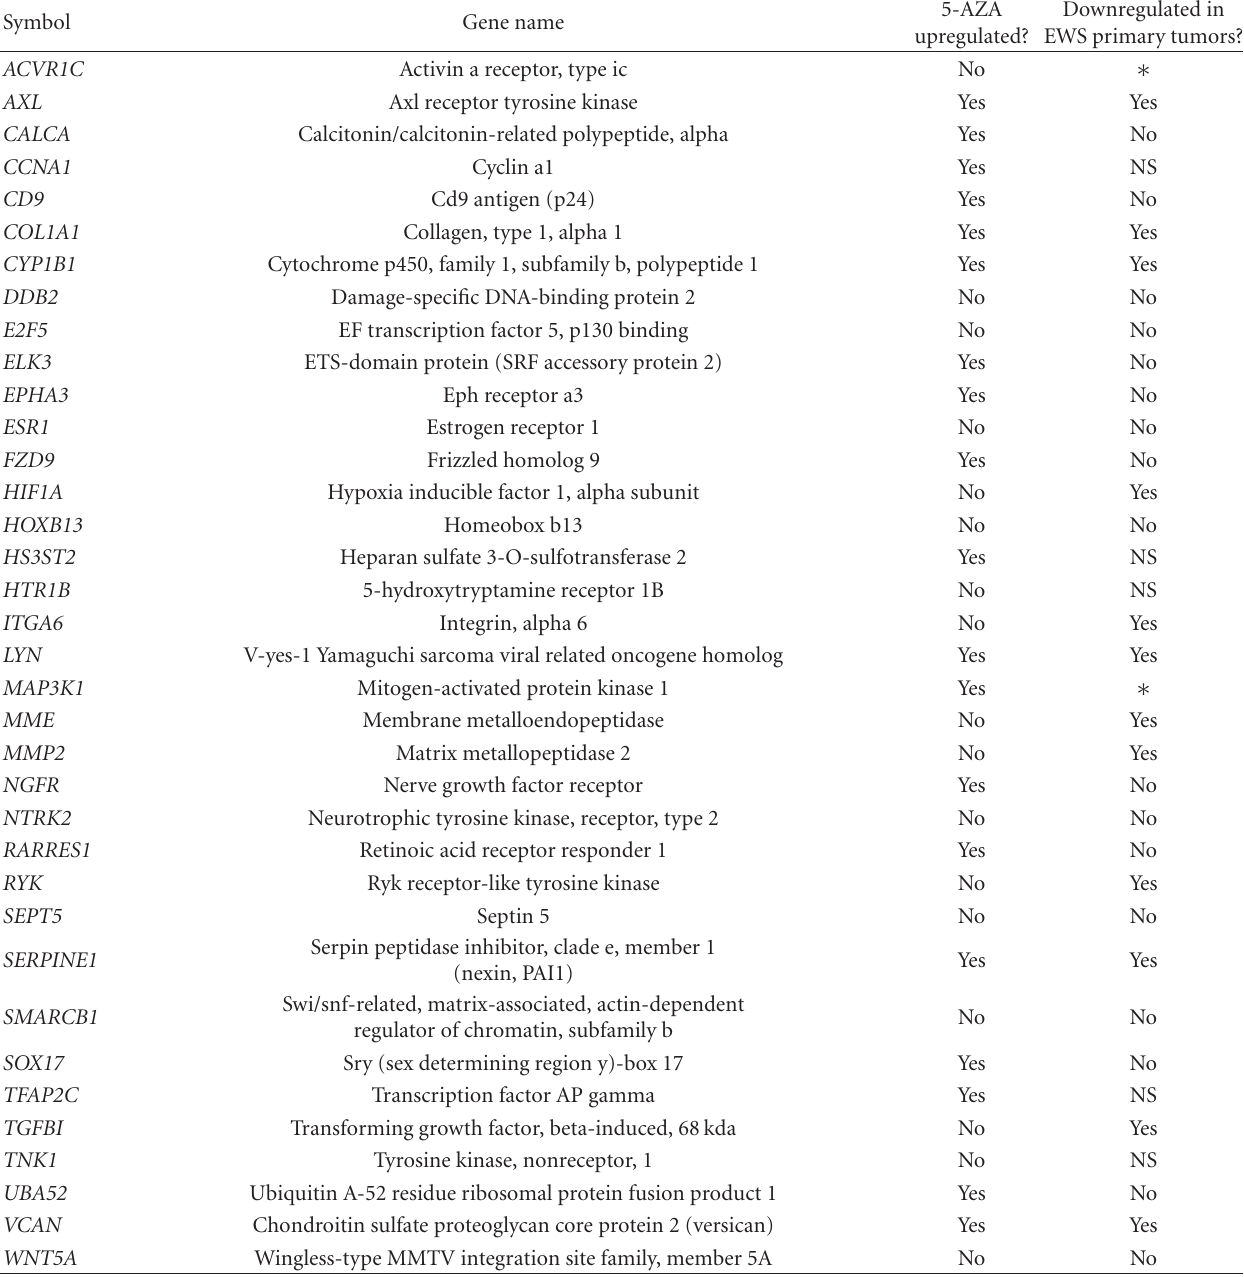
Table 1: Genes hypermethylated in EWS primary